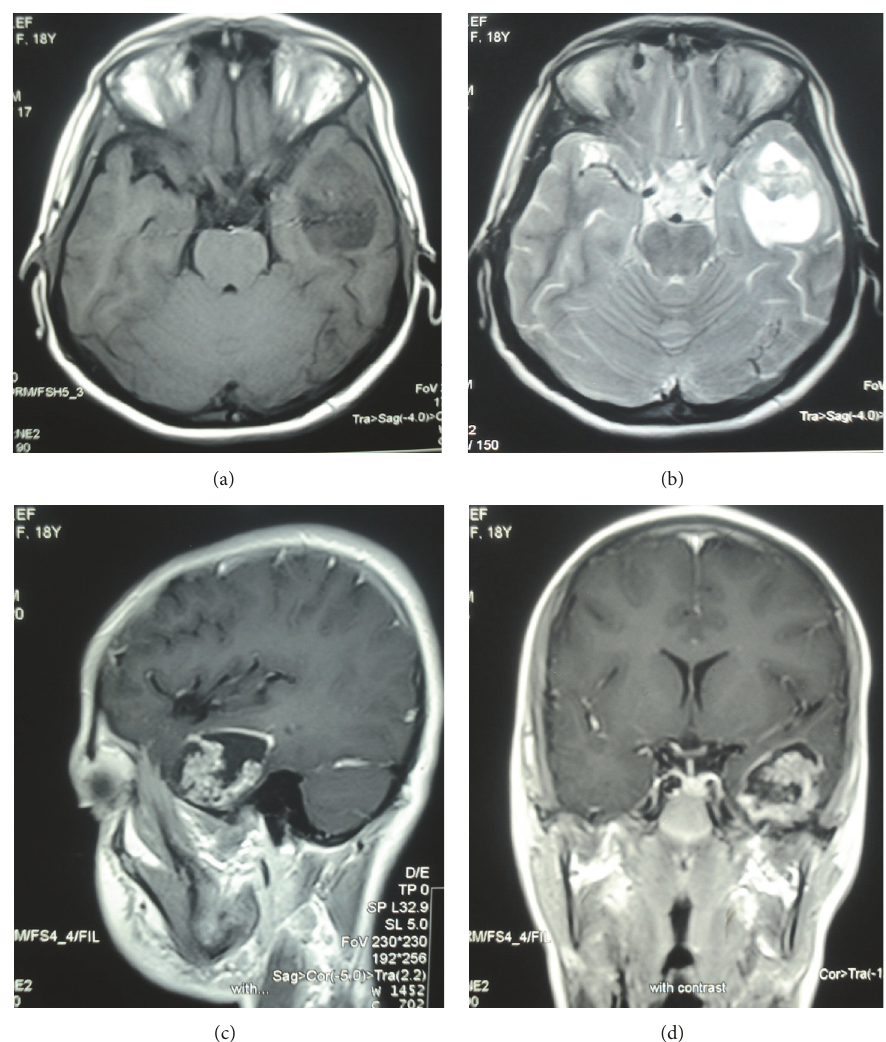
Figure 1: Craniopharyngioma of the left temporal lobe. Axial T1-weighted (a) and T2-weighted (b) MR images show a solid-cystic mass with no significant edema at left temporal lobe. Sagittal (c) and coronal contrast enhanced T1-weighted (d) MR images show peripheral wall enhancement and enhancing solid component.